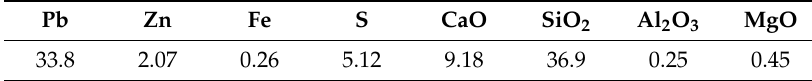
Table 6. Average main element analysis of leaching residues (wt %).